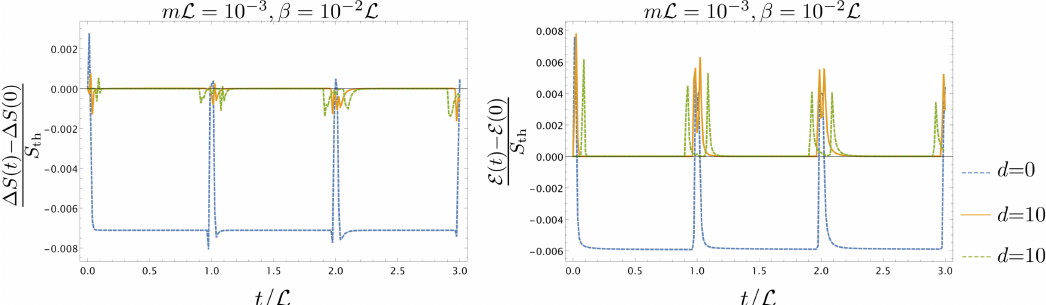
Figure 6 . Long-time behavior of ∆ S = S OEE − S EE and E in free massless scalar theory. We take